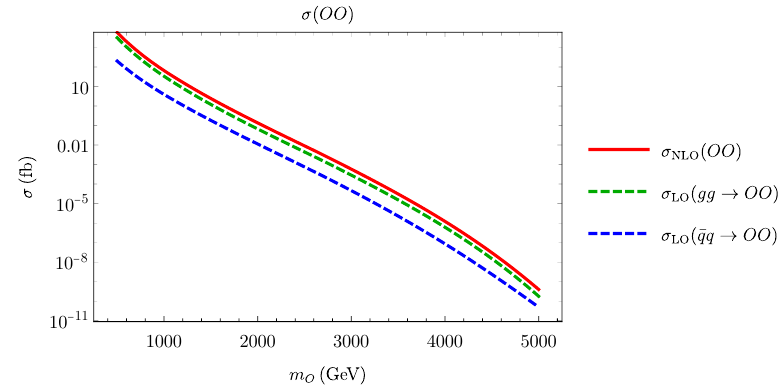
Figure 10. Cross sections of either scalar or pseudoscalar sgluon pair production due to gluon fusion and quark-antiquark